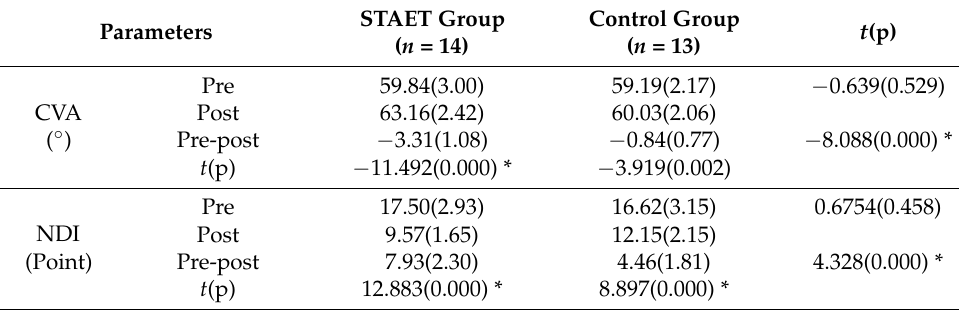
Table 6. Comparison of craniovertebral angle (N = 27).